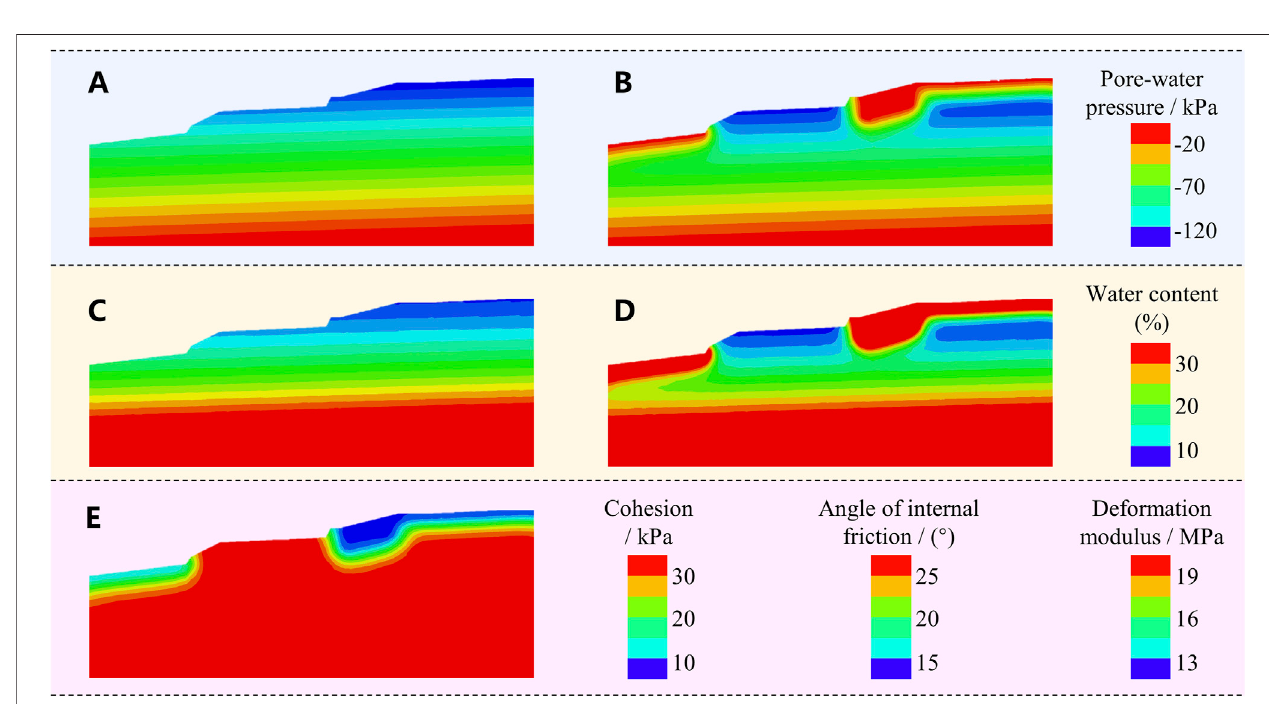
FIGURE8| Fieldsofthepore-waterpressurebefore (A) andafter (B) rainfallin fi ltration; fi eldsofthewatercontentbefore (C) andafter (D) rainfallin fi ltration;andthe fi tted fi elds of the cohesion, angle of internal friction and deformation modulus (E) .